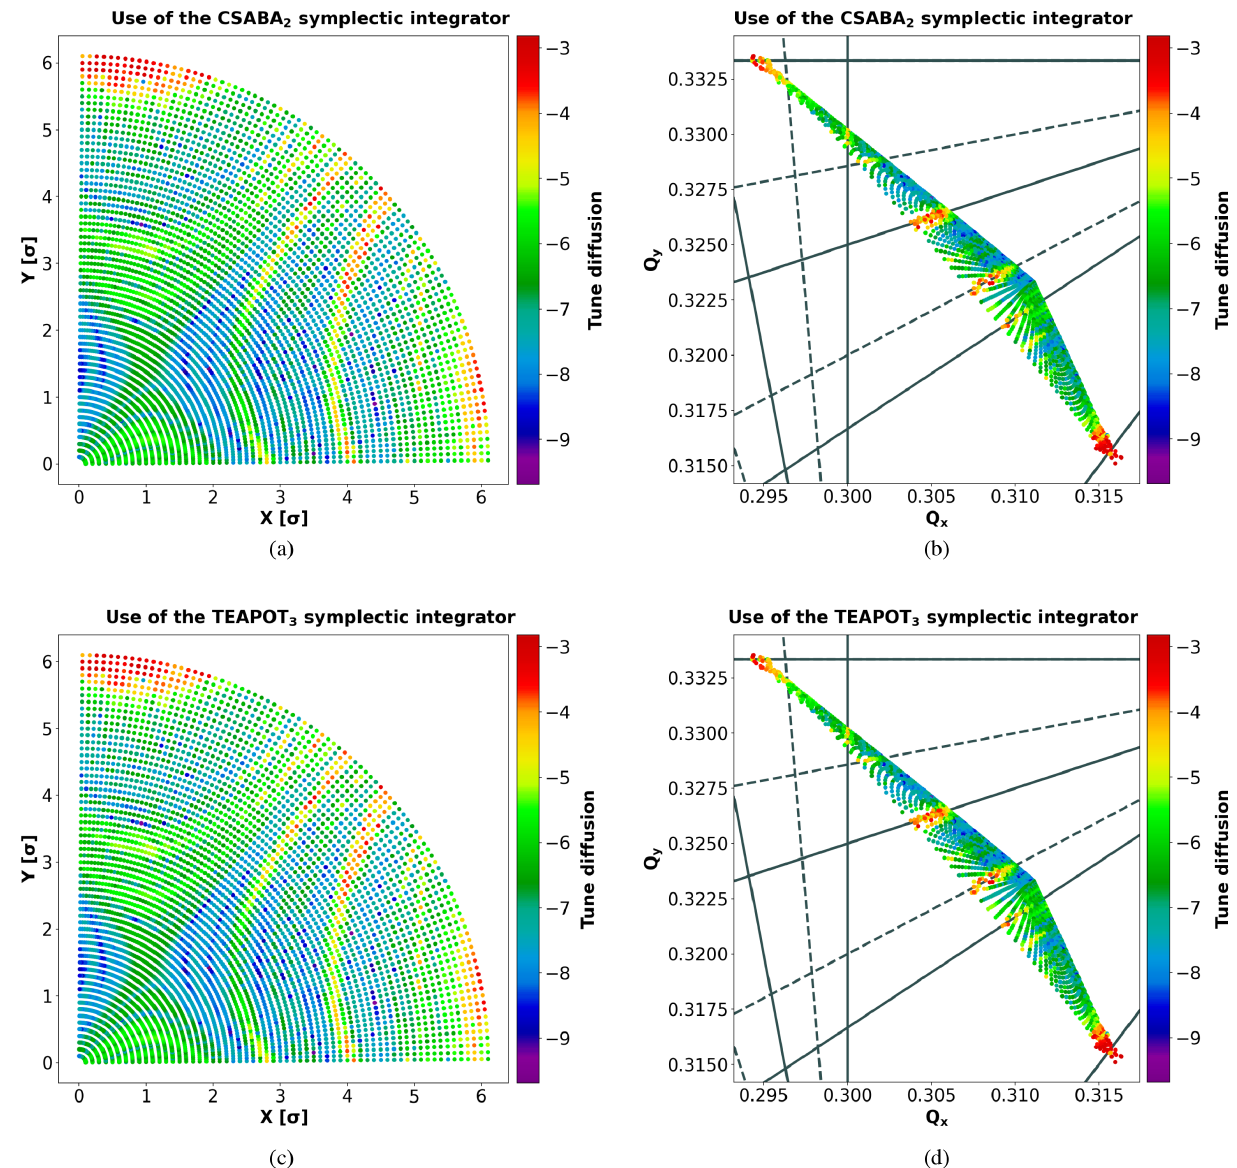
FIG. 6. Tune diffusion resulted from the use of the CSABA 2 symplectic integrator in (a) the coordinate space and (b) in the tune space. Tune diffusion resulted from the use of the TEAPOT 3 symplectic integrator in (c) the coordinate space and (d) in the tune